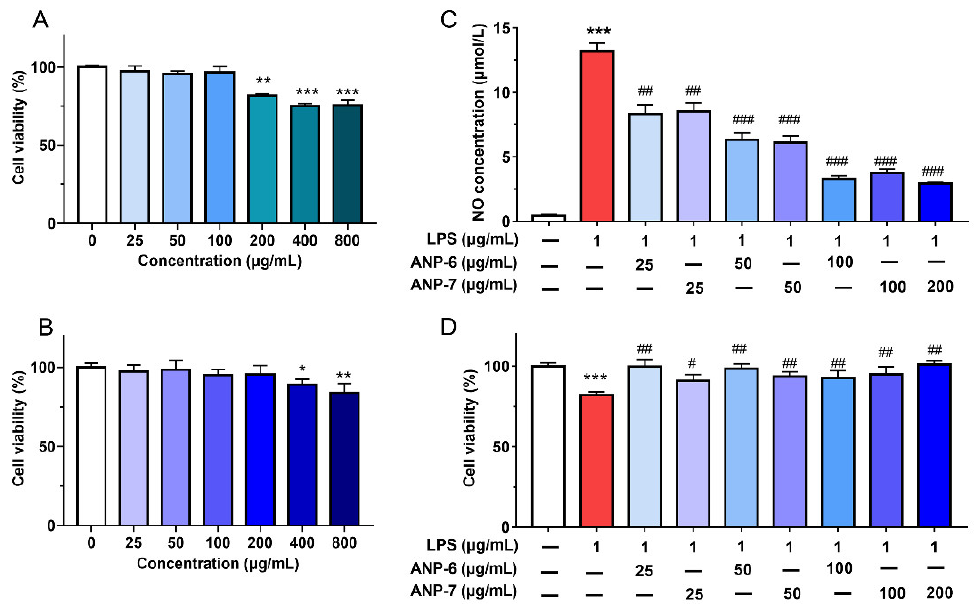
Figure 6. Effects of ANP-6 ( A ) and ANP-7 ( B ) on cell viability and NO production ( C ) and against LPS-induced toxicity ( D ). The results were expressed as means ± SD ( n = 6). Values are significantly different from the LPS group at # p < 0.05, ## p < 0.01, and ### p < 0.001. Or * p < 0.05, ** p < 0.01, and *** p < 0.001 against the control group.